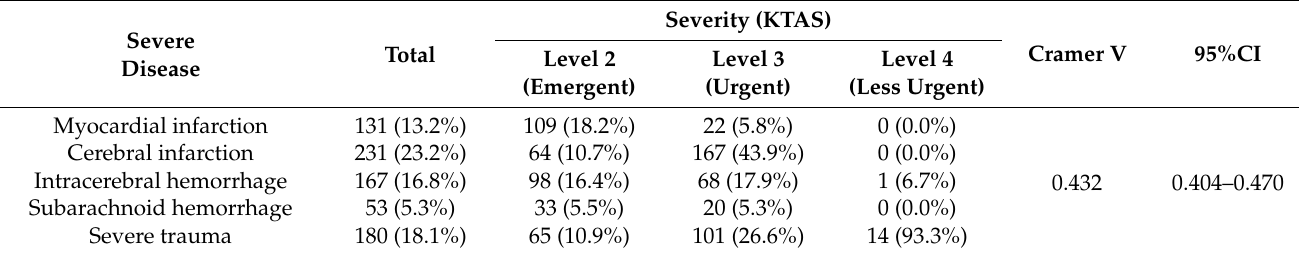
Table 6. Correlation between severe diseases and severity after the outbreak of